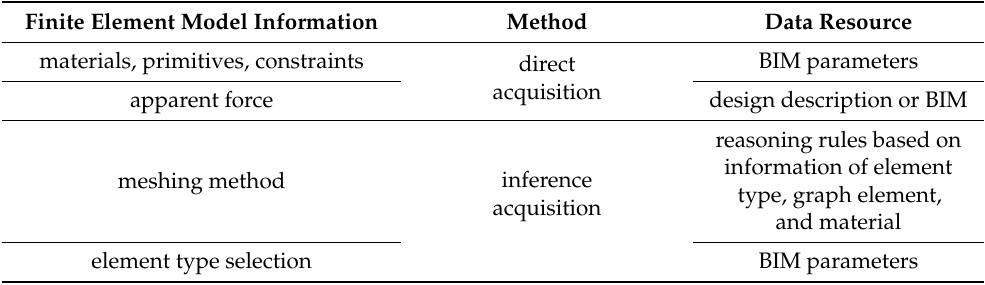
Table 4. The method of obtaining finite element model